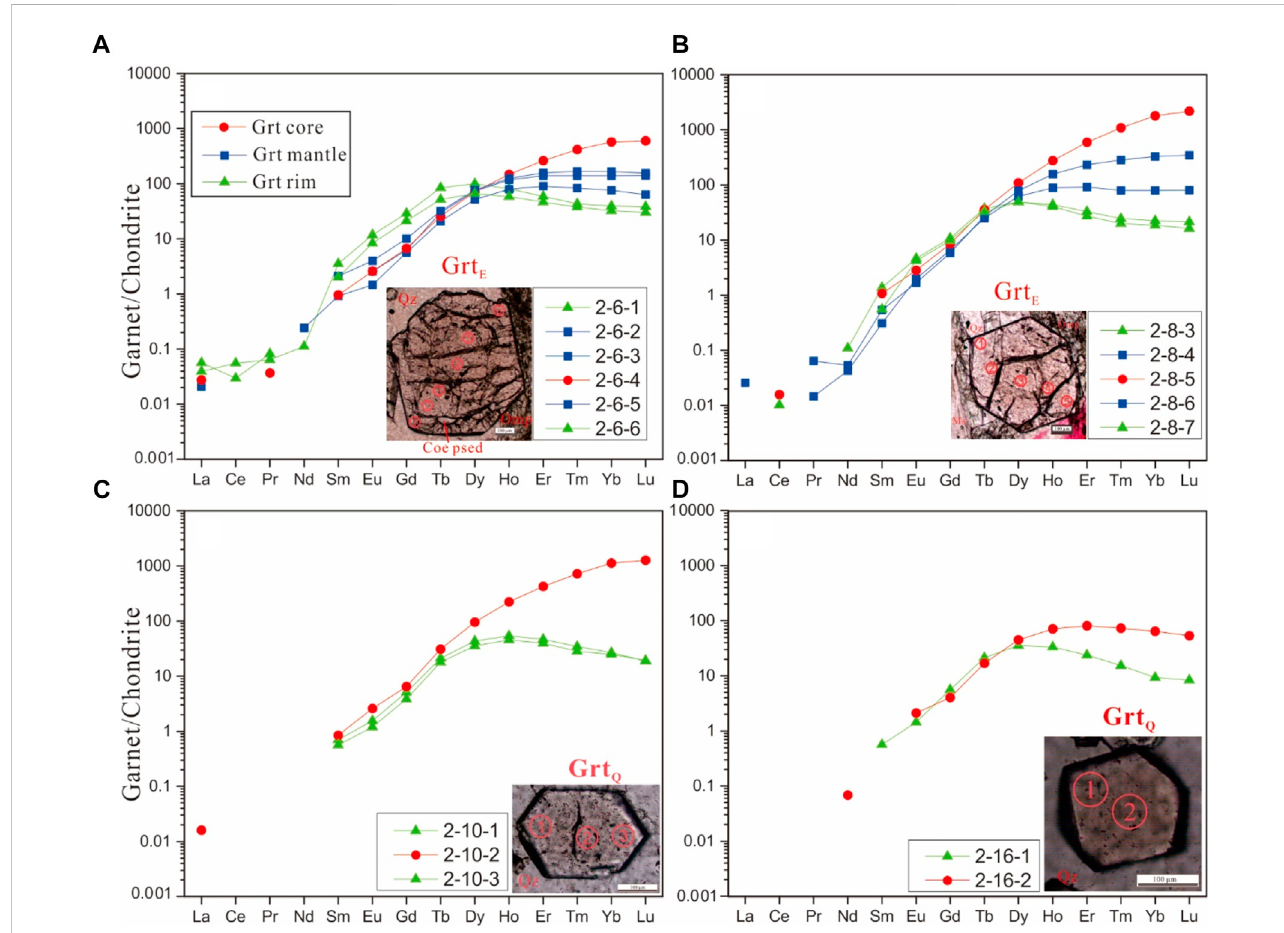
Chondrite-normalized REE distribution diagram for Grt E (A, B) and Grt Q (C, D) from the felsic schist sample